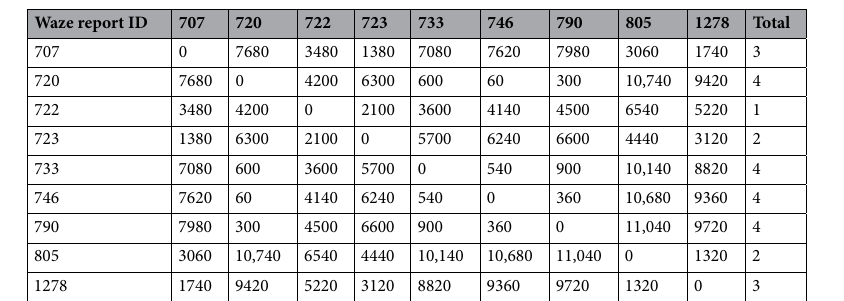
Table 1. Example temporal distance matrix for a group of highly clustered Waze events. Values are in seconds. Totals are for counts of Waze reports within 1800